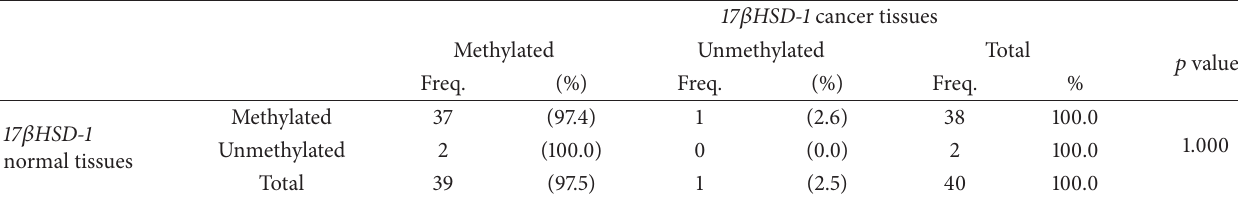
Table 7: Relation between methylation status of 17 𝛽 HSD-1 promoter in cancer tissue specimens and normal tissue specimens in 40 sporadic breast cancer patients.